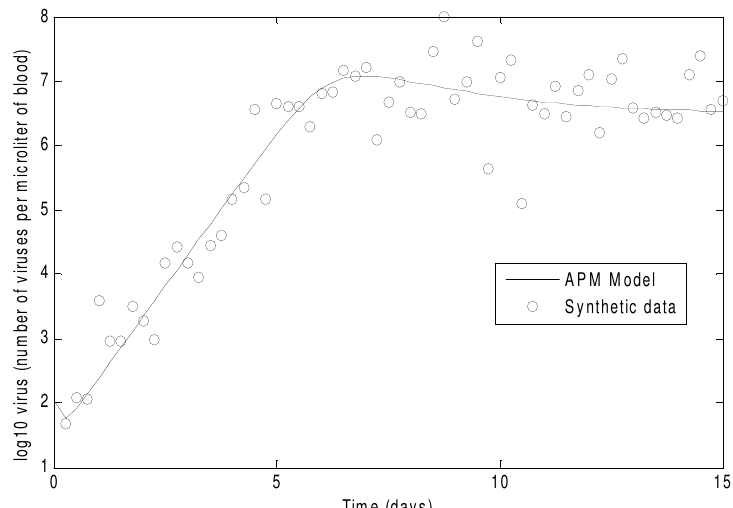
Figure 7. The parameters of the HIV model are adjusted to fit synthetic virus concentrations from simulated lab data.